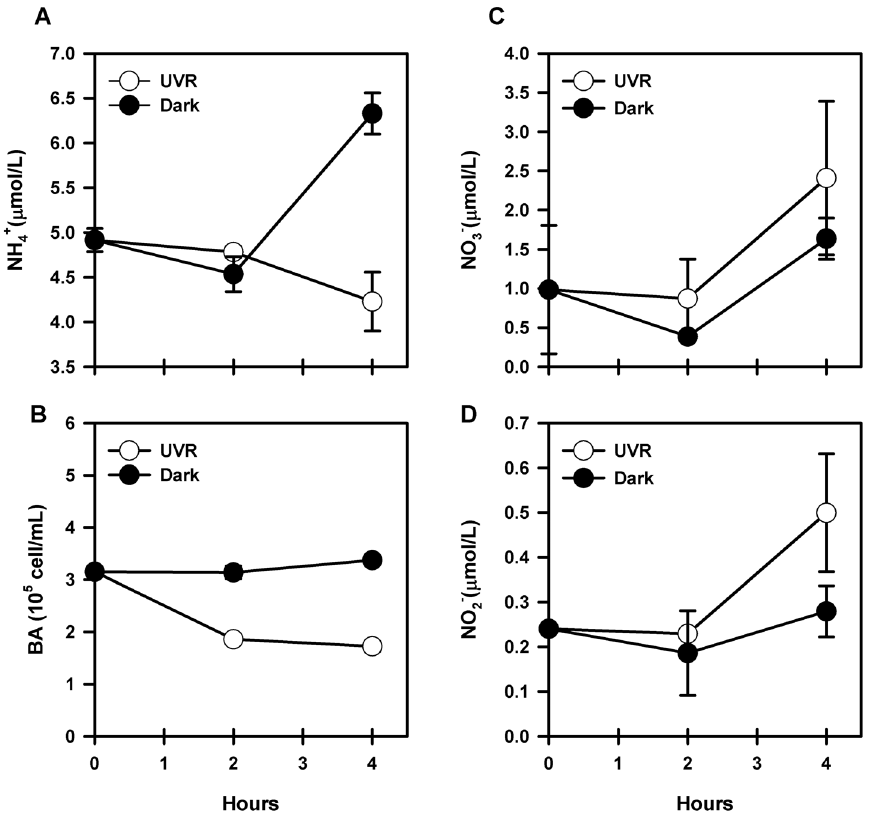
Figure 6. Evolution of nutrient concentration and bacterioplankton abundance during experiments of dissolved organic matter photodegradation (UVR vs Dark) using marine DOM (October 2011). A) Ammonium concentrations, B) bacterioplankton abundance (BA), C) Nitrate concentrations, D) Nitrite concentrations. All samples were taken in duplicate.